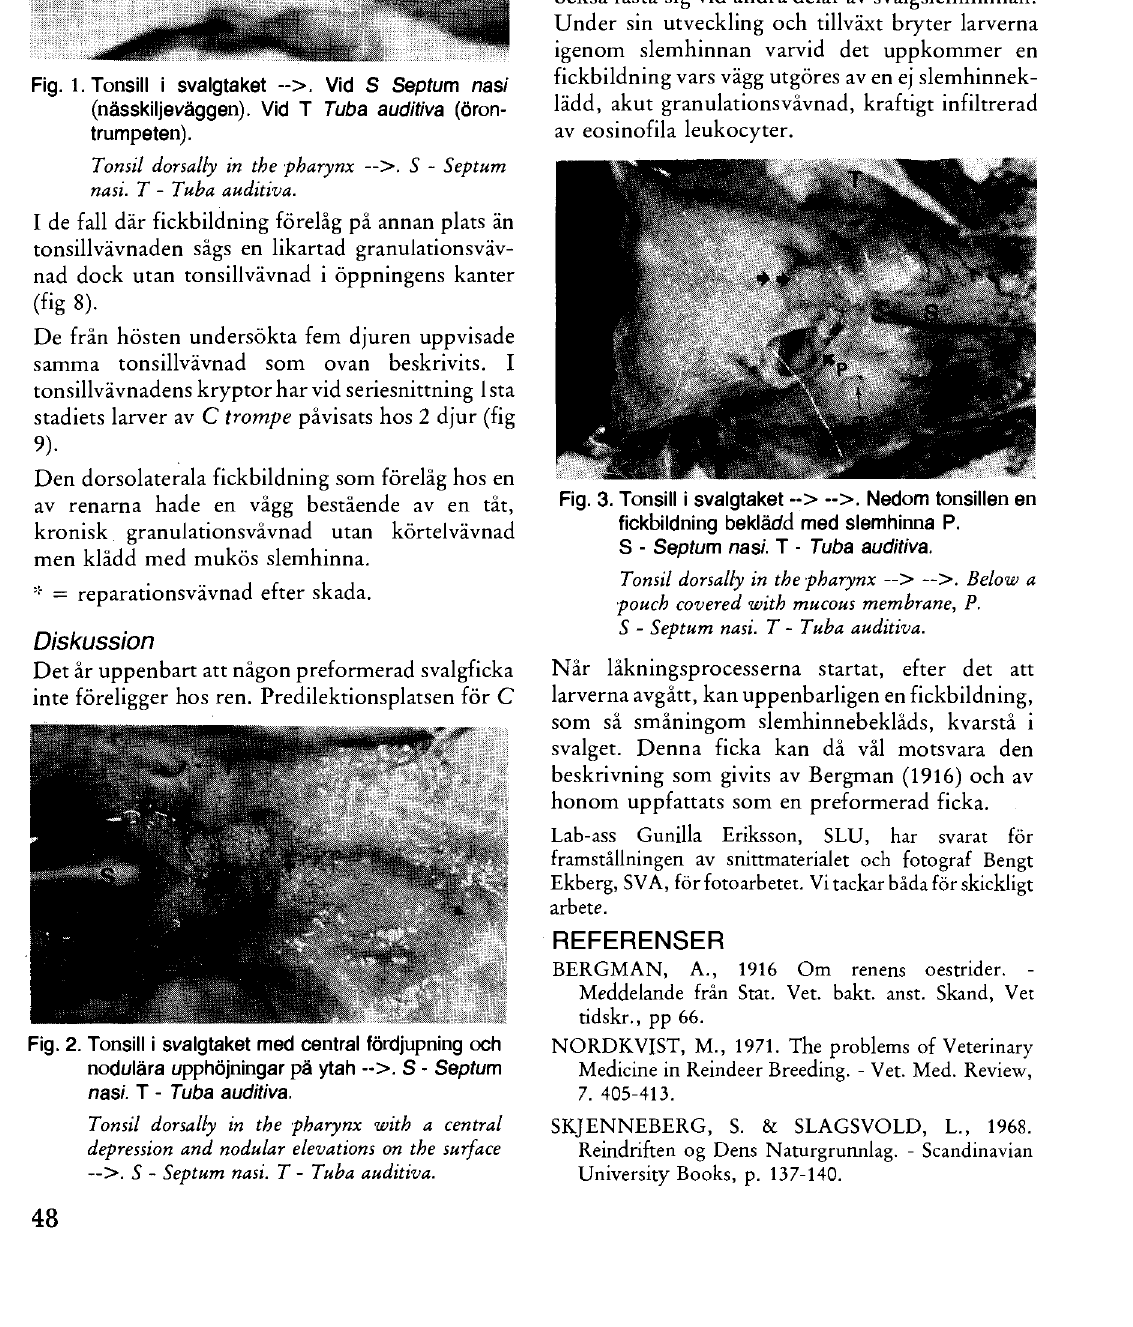
Fig. 1. Tonsill i svalgtaket -->. Vid S Septum nasi (nässkiljeväggen). Vid T Tuba auditiva (öron- trumpeten).